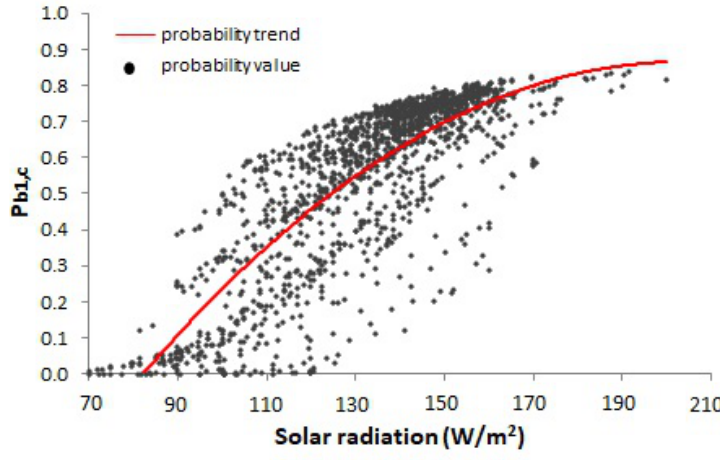
Figure 8. Distribution probability of blind closing by the occupant.